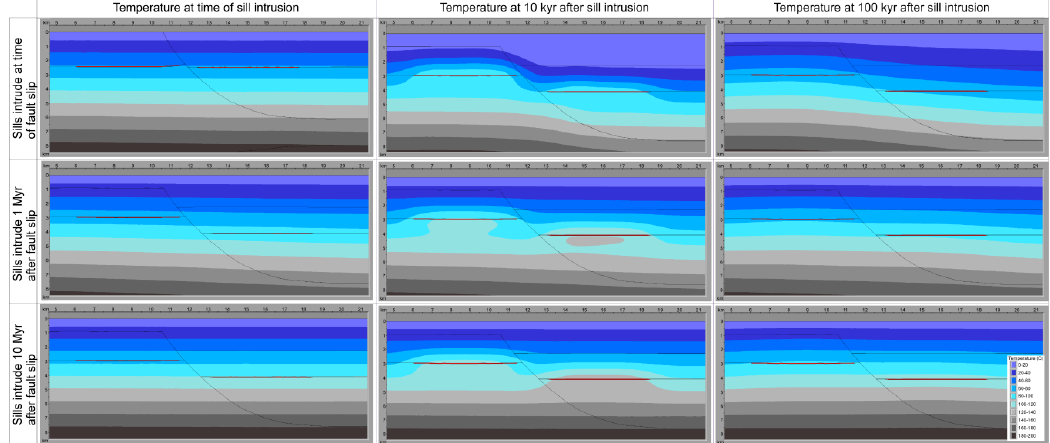
Figure 16. Temperature results for sills intruding with different timing in relation to fault slip. Temperatures to the left are at time of intrusion, in the middle, 10 kyr after intrusion, to the right, 100 kyr after intrusion.